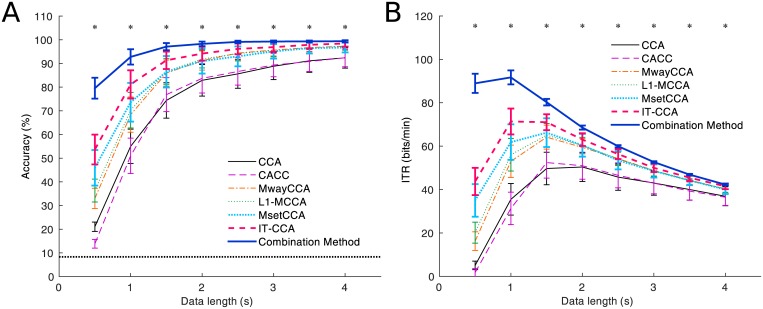
Performance comparison of seven CCA-based SSVEP detection methods.(A) Averaged classification accuracy and (B) simulated ITRs across subject using different data lengths. Error bars indicate standard errors. The asterisks indicate significant difference between different methods (*p<0.05).